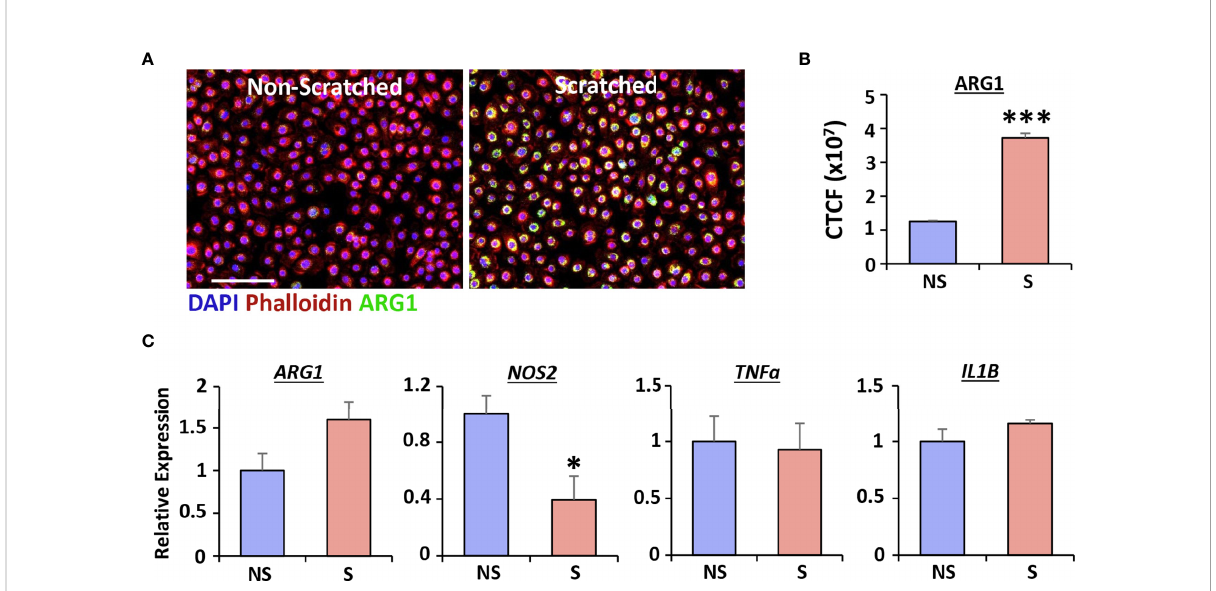
FIGURE 2 Injury induces Arginase 1 expression in human vaginal epithelial cells. qRT-PCR for ARG1, NOS2 , TNF a and IL1B ( A , n = 6). Immuno fl uorescence of Arginase 1 (ARG1) in non-scratched (NS) and scratched (S) cells (B) and quanti fi cation (C) . ARG1 = Alexa Fluor 488. Rhodamine phalloidin = cytoskeleton. DAPI = cell nuclei. Bar = 100 µm. CTCF = corrected total cell fl uorescence. Mean +/- SEM. Independent t tests performed. *= P < 0.05 and ***= P <